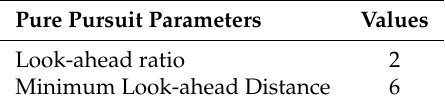
Figure 21. ( a ) illustrates the qualitative results between Pure Pursuit and MPC-based path follower. The difference between Pure Pursuit, and MPC-based path follower is shown in ( b , c ) respectively [24] (Best viewed in color). Table 6. Pure pursuit tuned parameters for 30 km/h